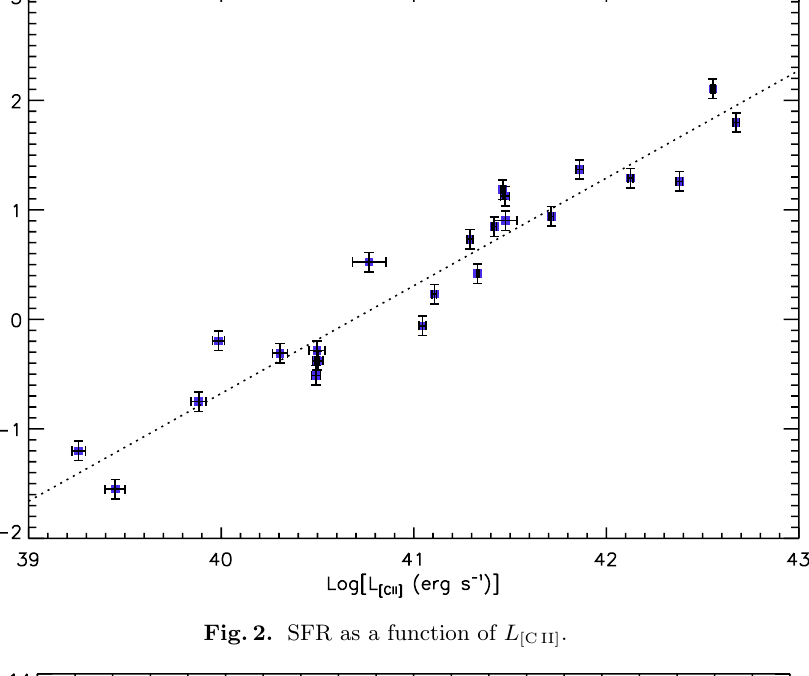
Fig. 2. SFR as a function of L [CII] .